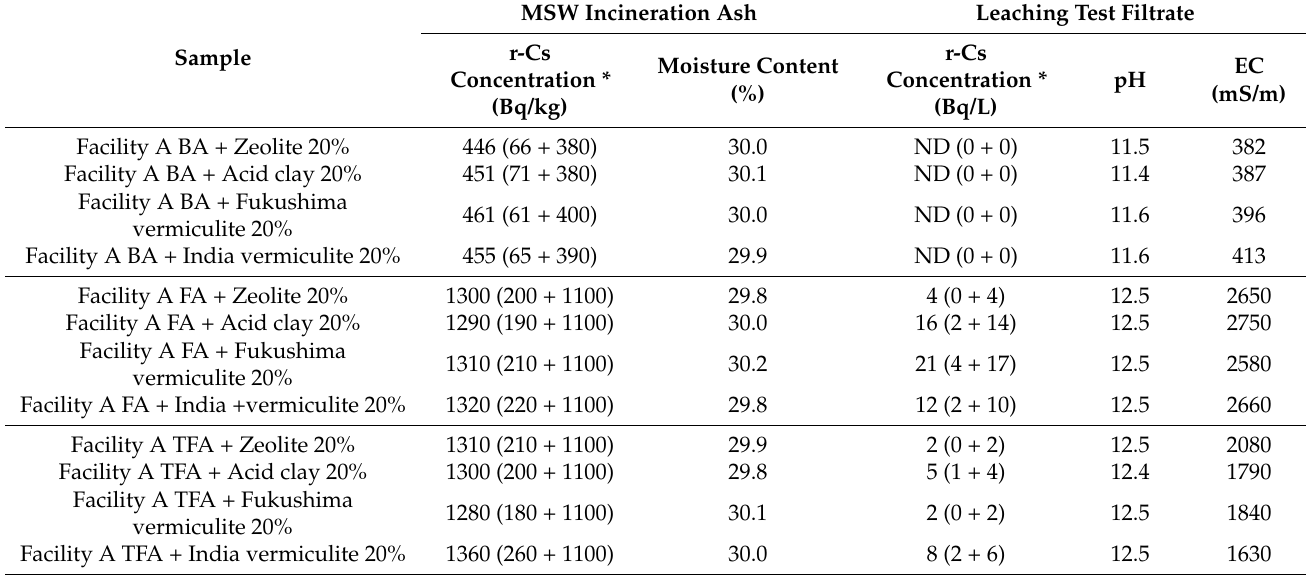
Table 5. Concentration and leaching of radioactive cesium (r-Cs) upon direct addition and mixing of clay minerals at 20